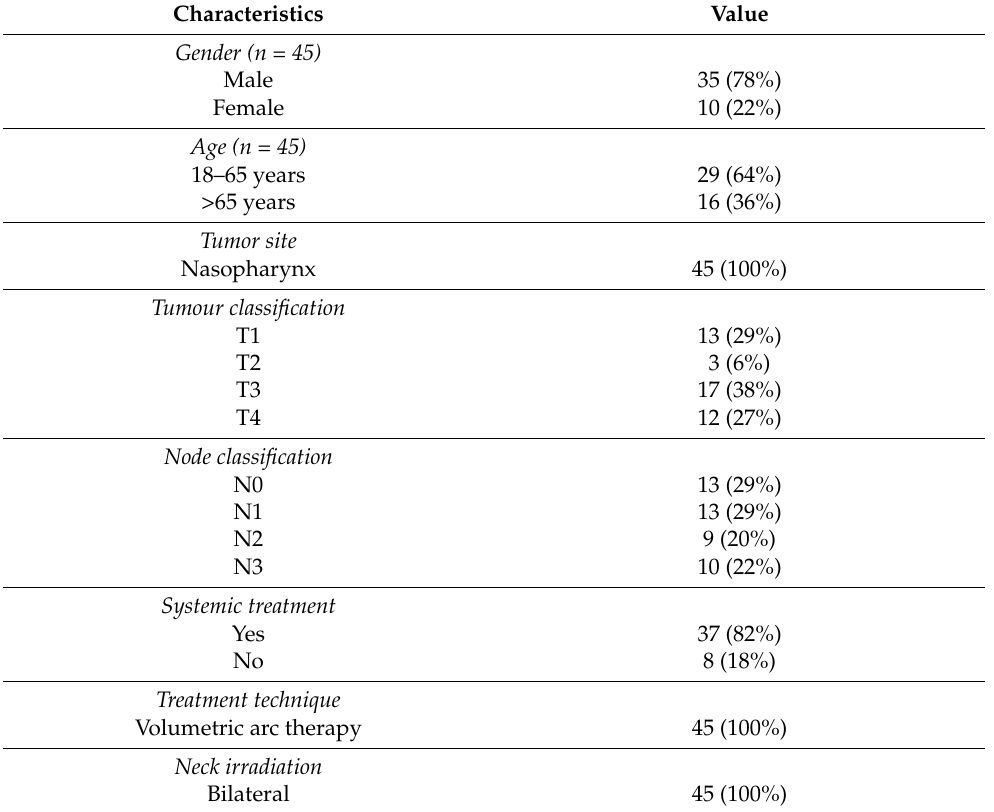
Table 1. Patient characteristics ( n =